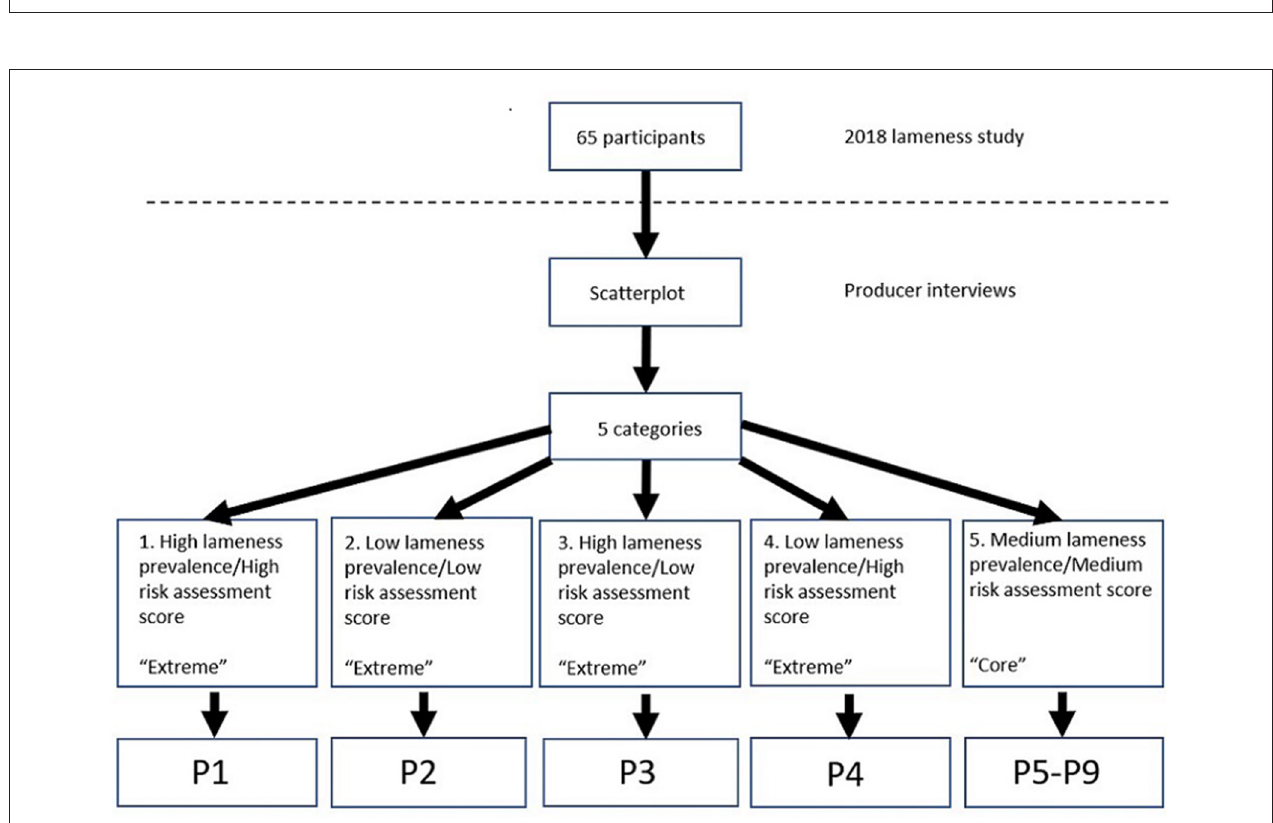
FIGURE 2 | Flowchart to represent the selection and categories of